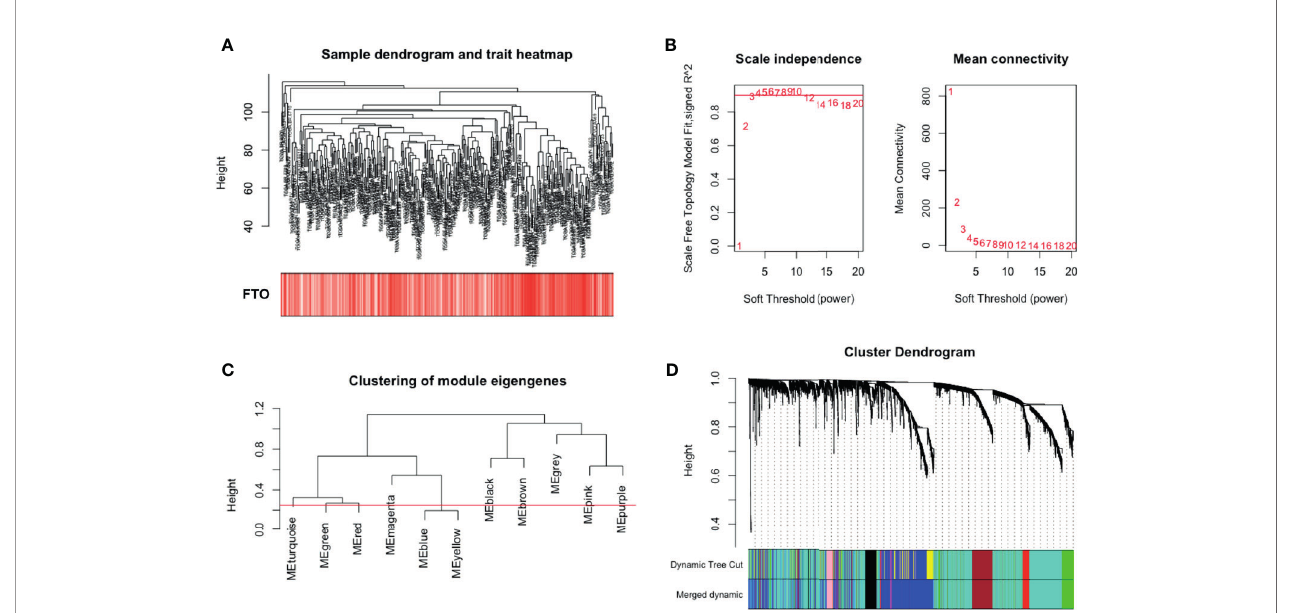
FIGURE 3 | Construction of weight co-expression modules of gastric cancer with FTO expression. (A) The clustering was based on the expression data from TGCA. (B) The left fi gure showed the correlation of various soft-thresholding power and scale independence. The right fi gure showed the effect of soft threshold power values on mean connectivity. (C) Similar gene modules were merged according to the MEDissThres 0.25 (Red line) by calculating eigengenes of each module. (D) A hierarchical clustering dendrogram was conducted by the Dynamic Tree Cutting method. The fi rst color band indicates the modules detected by dynamic tree cut. The second color band indicates the modules after merging similar modules.